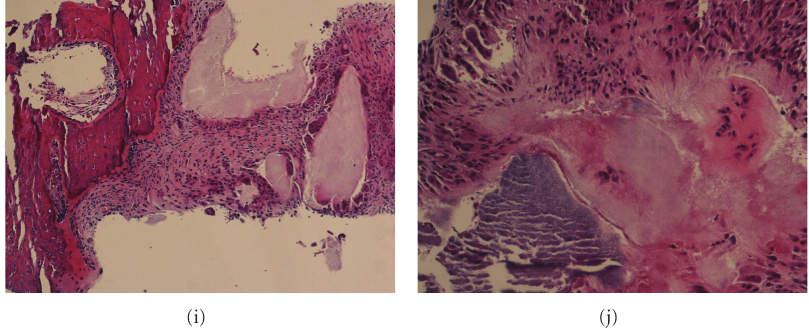
Figure 2: (a) Lateral and (b) sky line view radiographs of the patella demonstrate a well-defined slightly expansile lytic lesion with sclerotic margin in the mid lateral aspect of the patella (arrowheads) and knee joint e ff usion (star). On the skyline view, there is also evidence of a bipartite patella (black arrows). Sagittal (c) T1-WSE and (d) T2-WGE and (e) coronal T2-WSE MR images demonstrate a well-defined mass in the patella (black arrows) that displays intermediate SI on T1-W and moderately increased SI on T2-W MR images. Note the prepatellar bursitis (chevrons) and reactive joint e ff usion (white arrow). Axial T1-WSE fat saturated (f) before and (g) after gadolinium MRI images, show avid enhancement of the patellar lesion (black arrows), involvement of the adjacent lateral parapatellar soft tissues and lateral retinaculum (arrowhead), and enhancing reactive synovitis (chevrons). (h) Core biopsy at low power, (i) core biopsy at medium power, and (j) core biopsy at high power stained with H&E. There are aggregates of amorphous eosinophilic material with a surrounding foreign body giant cell and histiocyte reaction consistent with